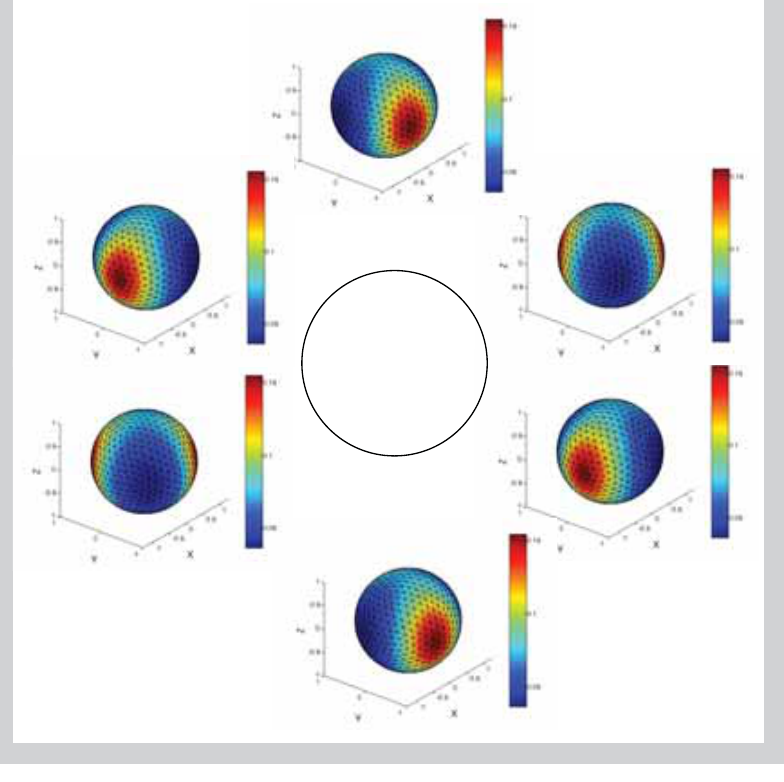
Figure 10 (above): Steady 3D fiber orientation distribution at some loca- tions on the circular trajec- tory. Figure 11: 3D orientation approxima- ( p tion functions F j